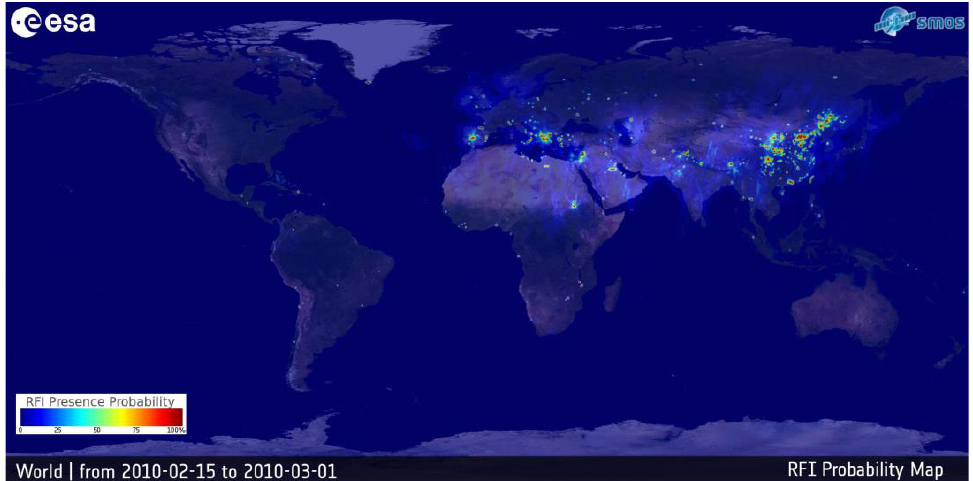
Figure 5. SMOS RFI Worldwide probability map generated automatically by dedicated scripts at ESAC.